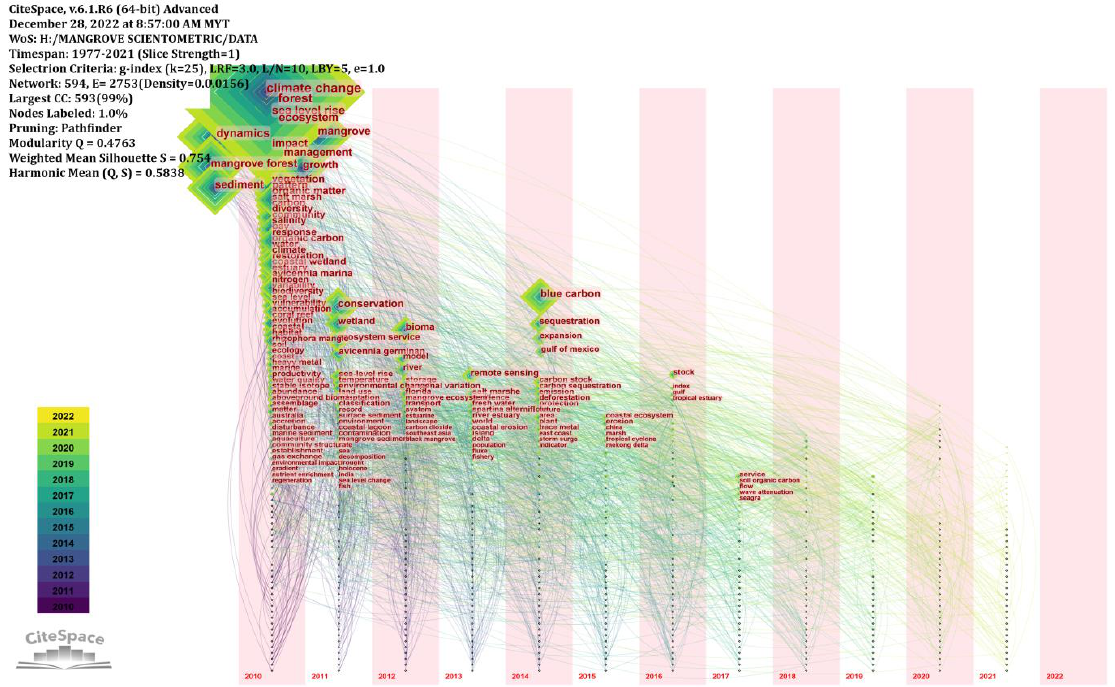
Figure 12. Keyword co-occurrence network from 2010 to 2021 for mangrove and climate change- related publications.